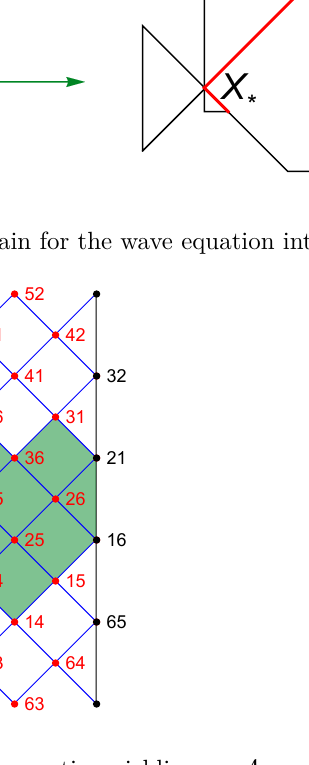
Figure 12 . A domain for the wave equation yielding an A 3